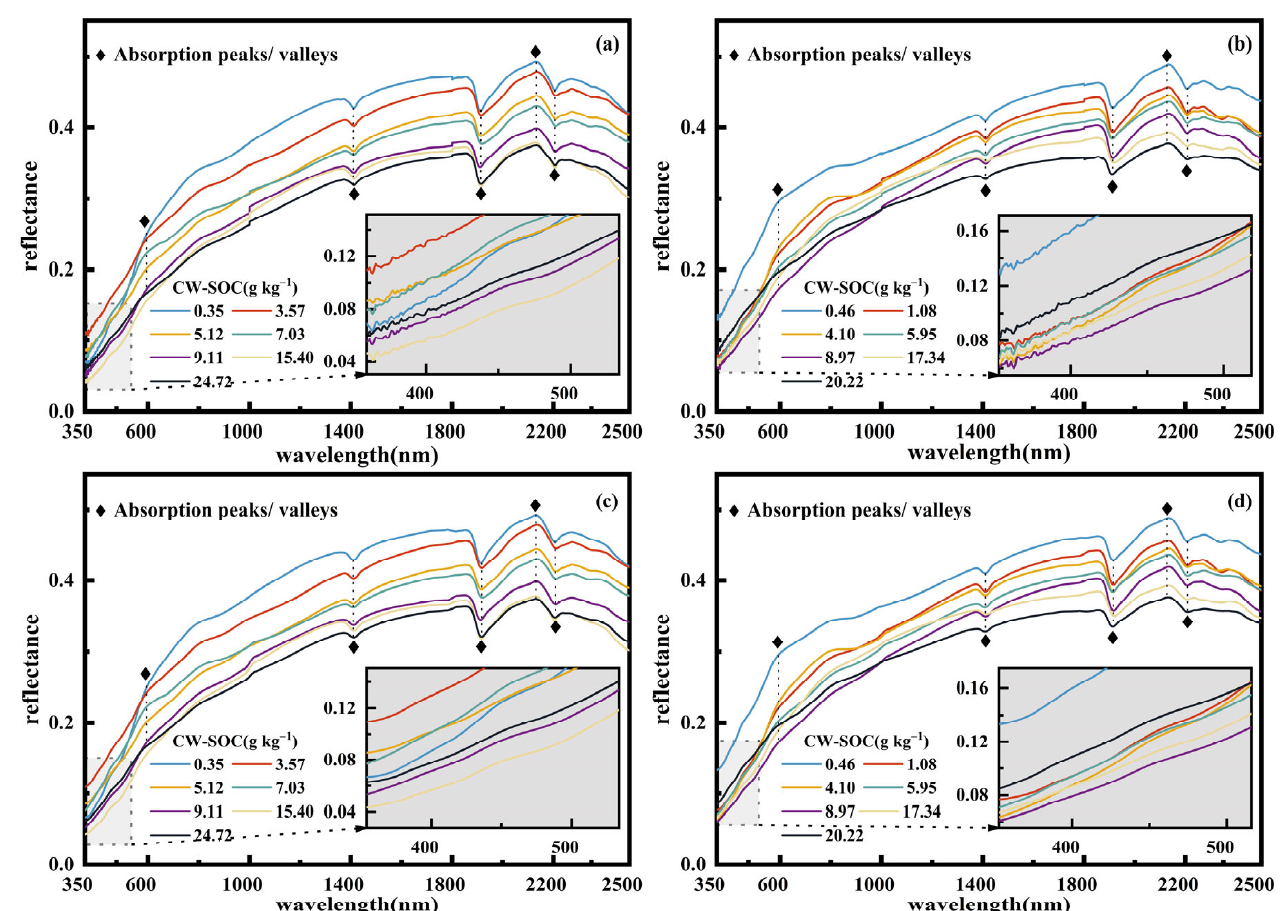
Figure 2. Soil sample reflectance curve before and after S ‐ G convolution smoothing. ( a ) Silty Soil: laboratory measured spectra; ( b ) Sandy Soil: laboratory measured spectra; ( c ) Silty Soil: S ‐ G convolution smoothing; ( d ) Sandy Soil: S ‐ G convolution smoothing.